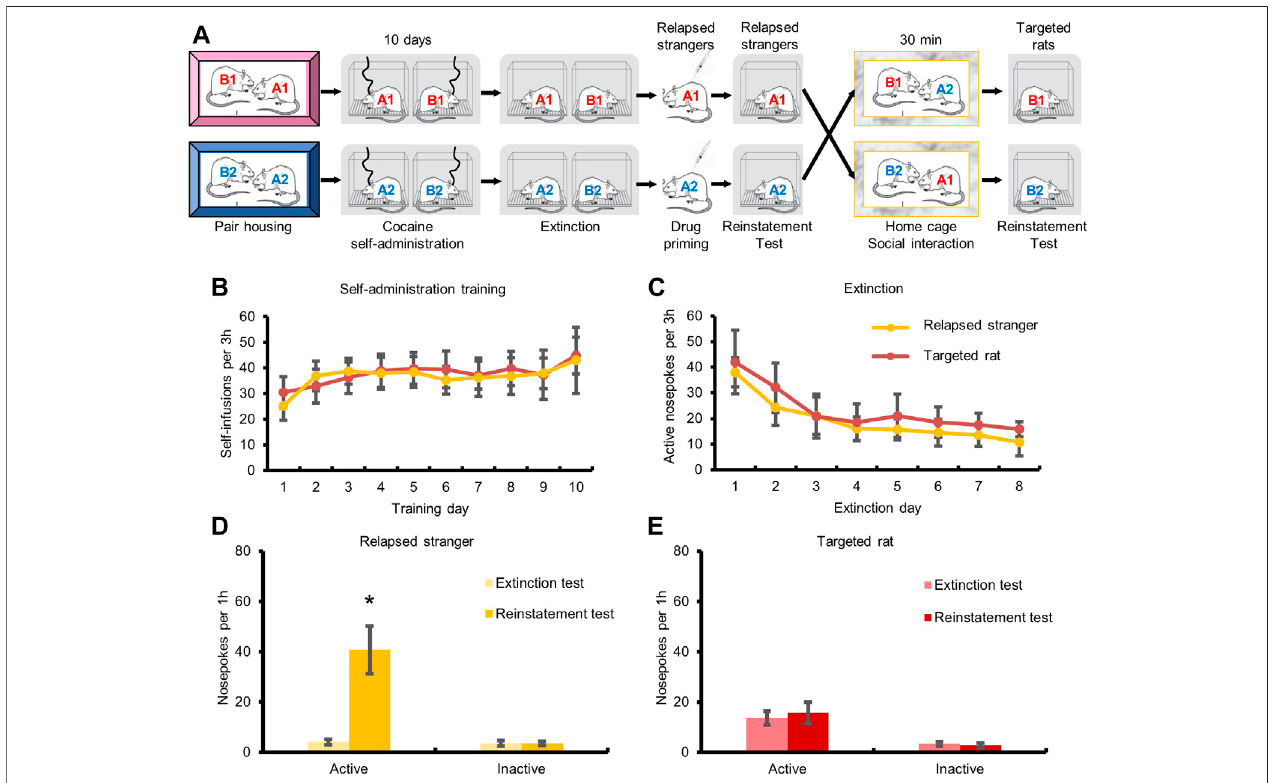
FIGURE 3 | Social interaction with relapsed strangershad no effect on drug-seeking behavior. (A) Experimental timeline. (B) Targeted rats and strangers acquired cocaine self-administration training. (C) Drug-seeking behavior of targeted rats and strangers was extinguished. (D) Cocaine injection triggered drug-seeking behavior. (E) Drug-seeking behavior of targeted rats had no change after social interaction with relapsed stranger (Data are shown as mean ± SEM. * p < 0.05, compared with extinction test. n (cid:1)